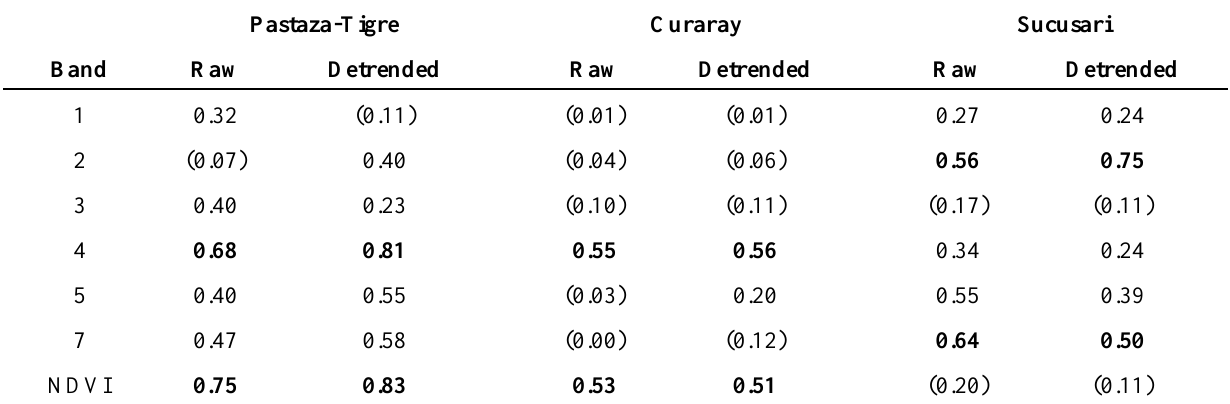
Table 1. Relationship between Landsat and floristic data for three study areas in northern Peruvian Amazonia. Values are the coefficients of determination (r 2 ) for linear regressions between individual Landsat bands (measured by digital numbers or detrended digital numbers) or NDVI as independent variables, and the main floristic gradient (measured by a single NMDS axis) as dependent variables, based on either unprocessed (“Raw”) or detrended (“Detrended”) Landsat images. All values are significant at P < 0.001, with the exception of values in parentheses. The two highest r 2 values for each image are presented in bold. Pastaza-Tigre Curaray